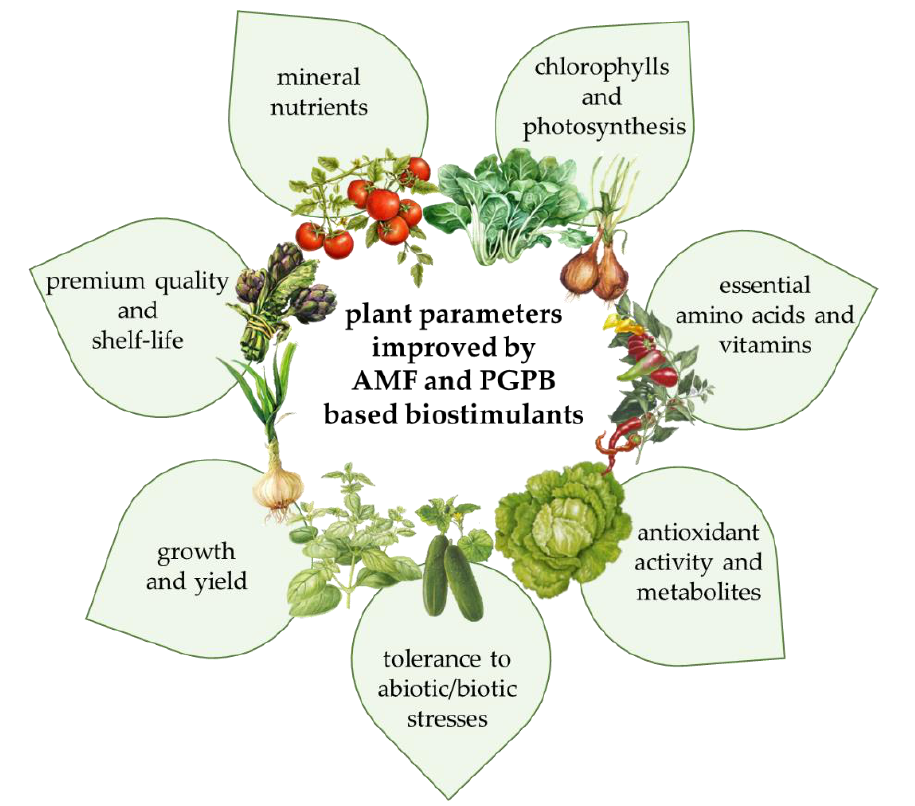
Figure 2. Main beneficial effects exerted by AMF and PGPB on vegetable crops in relation to yield and nutritional quality.